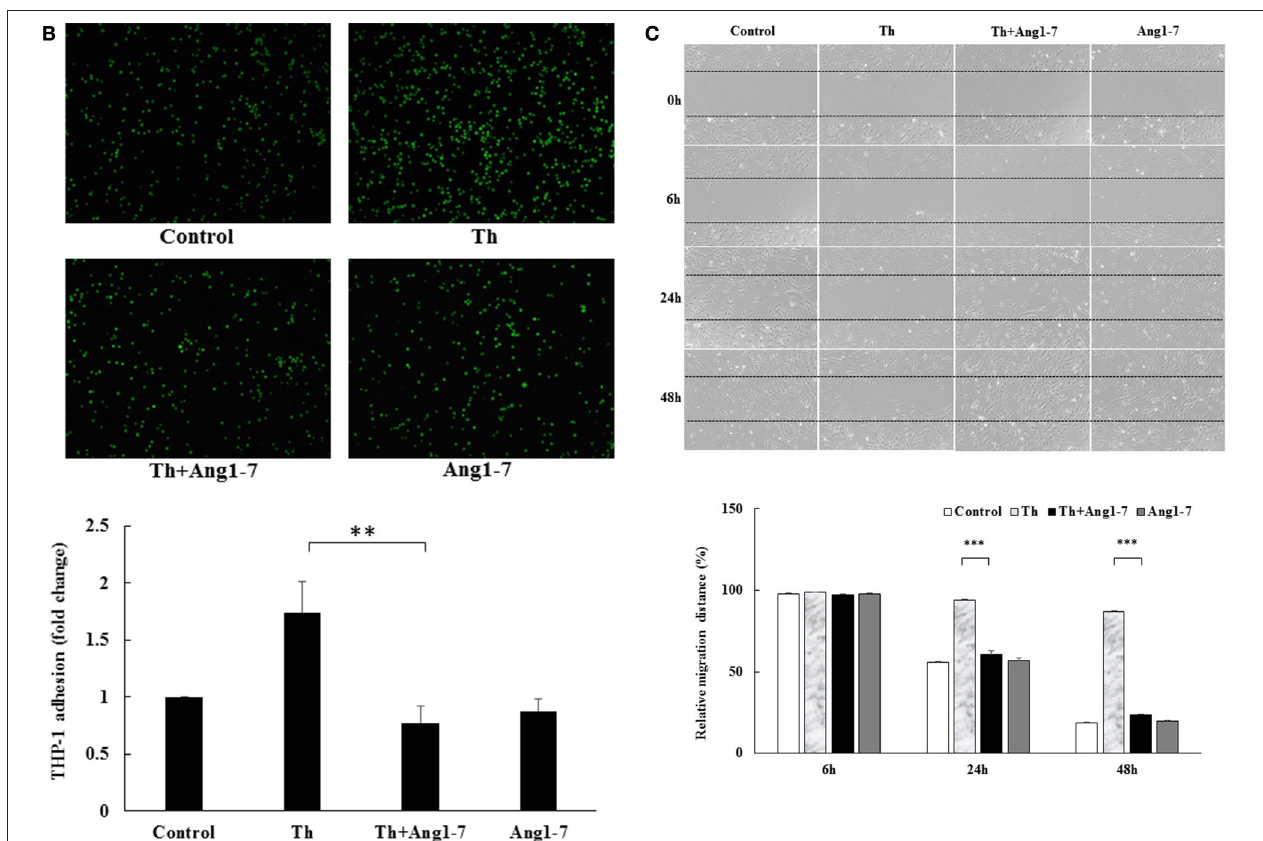
FIGURE 1 | three independent experiments. Th, thrombin. Ang1-7, angiotensin-(1-7). PI, propidium iodide. Scale bar = 50 µ m. (B) HAECs were stimulated with thrombin (2 U/mL) for 5h with or without 100nM angiotensin-(1-7) pretreatment 1h before the thrombin stimulation. Thrombin stimulation caused a significant increase in monocyte adhesion to HAECs, while angiotensin-(1-7) pretreatment caused a significant inhibition in monocyte adhesion. n = 6, ** p < 0.01 for thrombin compared with thrombin + angiotensin-(1-7) treatment. (C) HAECs were stimulated with thrombin (2 U/mL) for 24 and 48h with or without 100nM angiotensin-(1-7) pretreatment 1h before the thrombin stimulation. Thrombin induced a significant impairment in wound-healing migration, while angiotensin-(1-7) pretreatment prevented migration inhibition at 24 and 48h. n = 3. *** p < 0.001 for thrombin compared with thrombin +